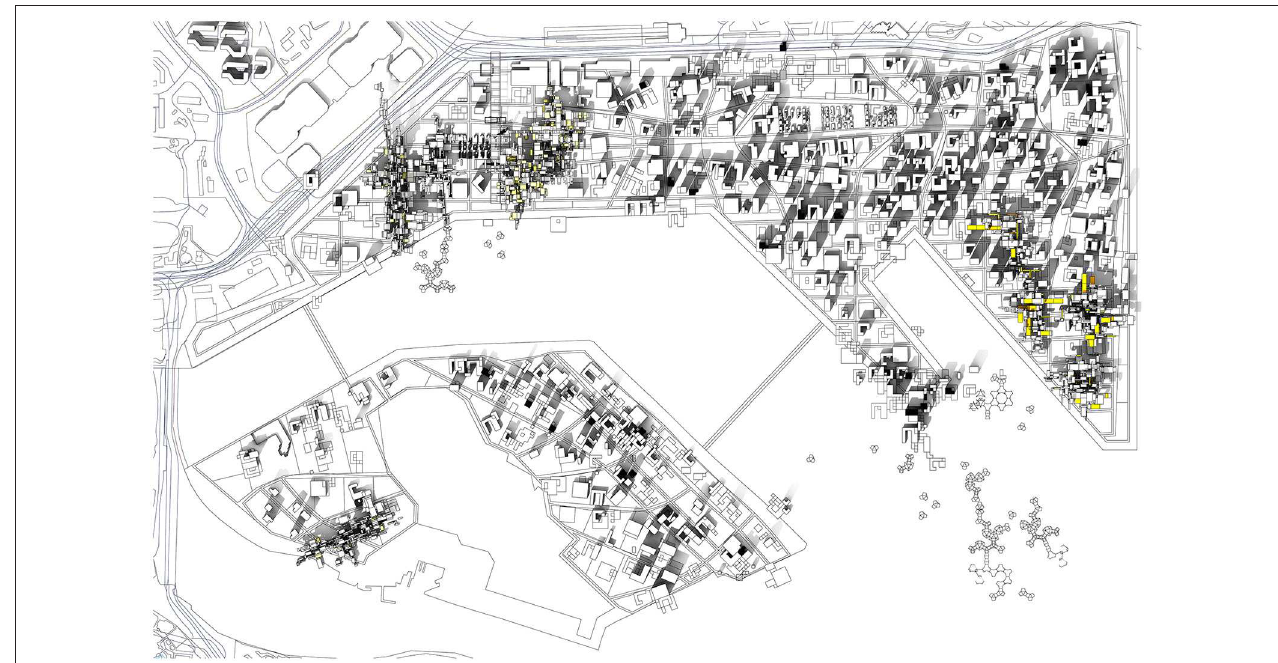
FIGURE 1 | An initial proto-masterplan for the adaptive city of Tanjong Pagar waterfront area in Singapore with customized responsive